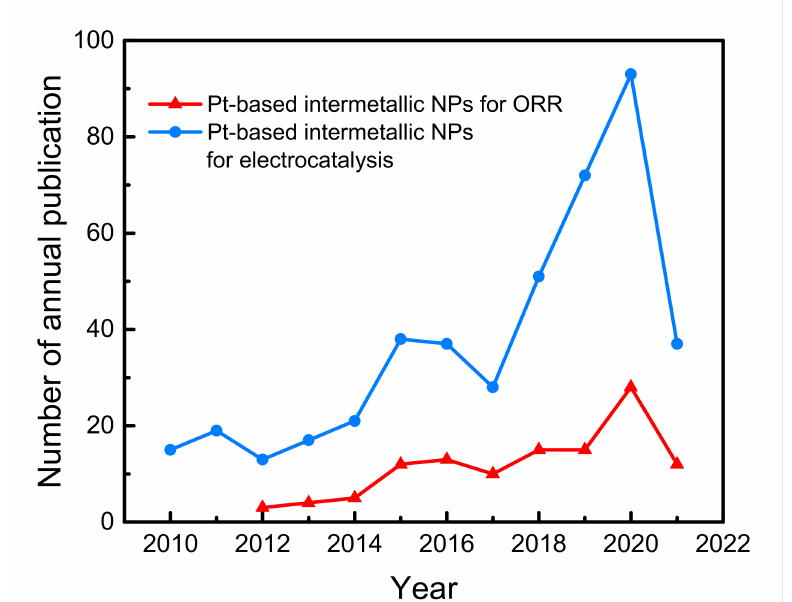
Figure 1. Number of articles on Pt-based intermetallic NPs in the field of ORR or electrocatalysis in the last decade according to Clarivate